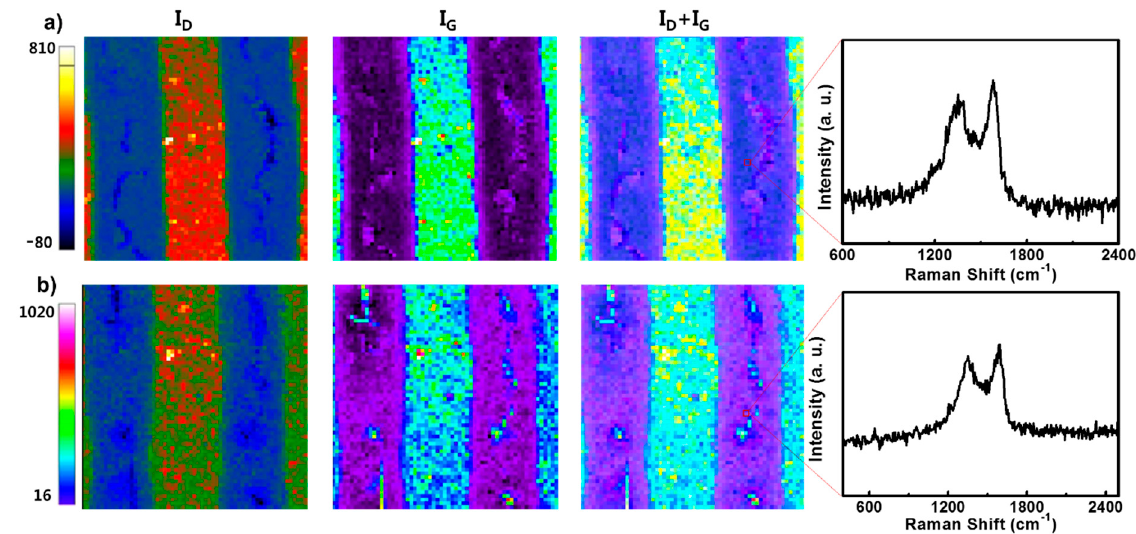
Figure 6. Raman mapping of ( a ) energy density is 19 J/cm 2 , ( b ) energy density is 26 J/cm 2 (300 × 300 μ m 2 ).